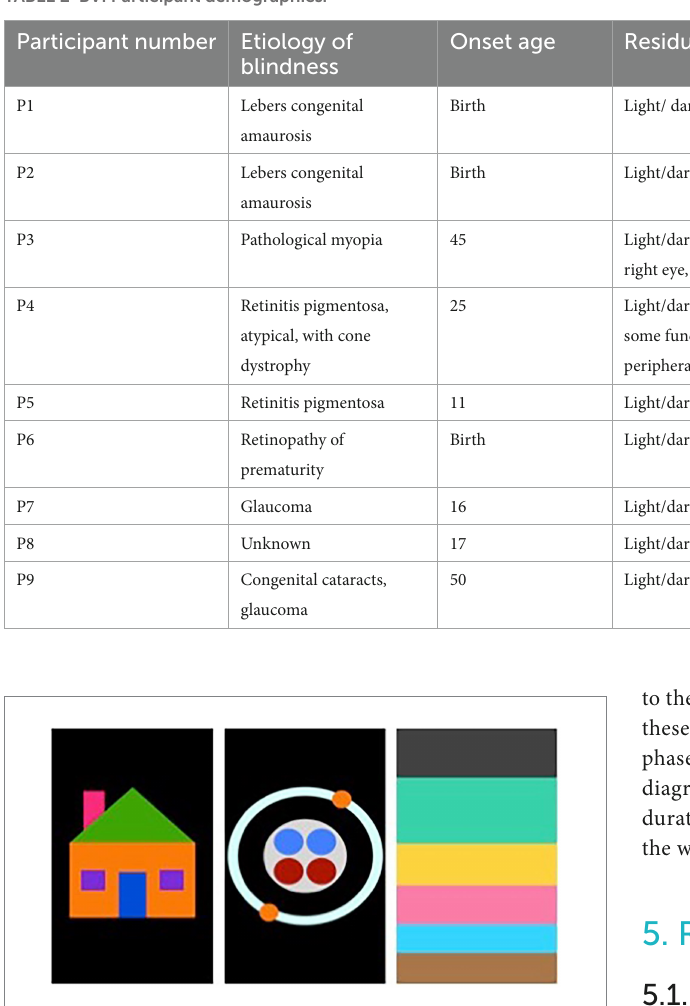
FIGURE 2 Example visualizations of the audio-haptic diagrams from left to right: practice diagram (house), atom diagram, and atmosphere diagram. Each color represents a unique element in the diagram. The phone screen was disabled via screen curtain throughout the study, so participants did not have visual access to the